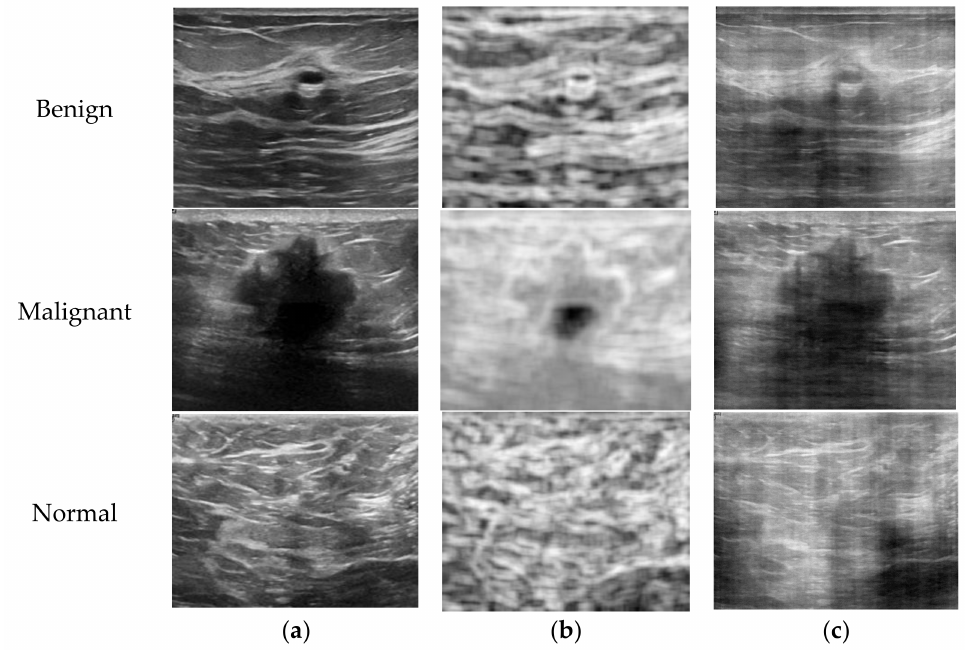
Figure 2. Sample B-mode, entropy, and phase images for a patient in each class; ( a ) B-mode images, ( b ) entropy images, and ( c ) phase